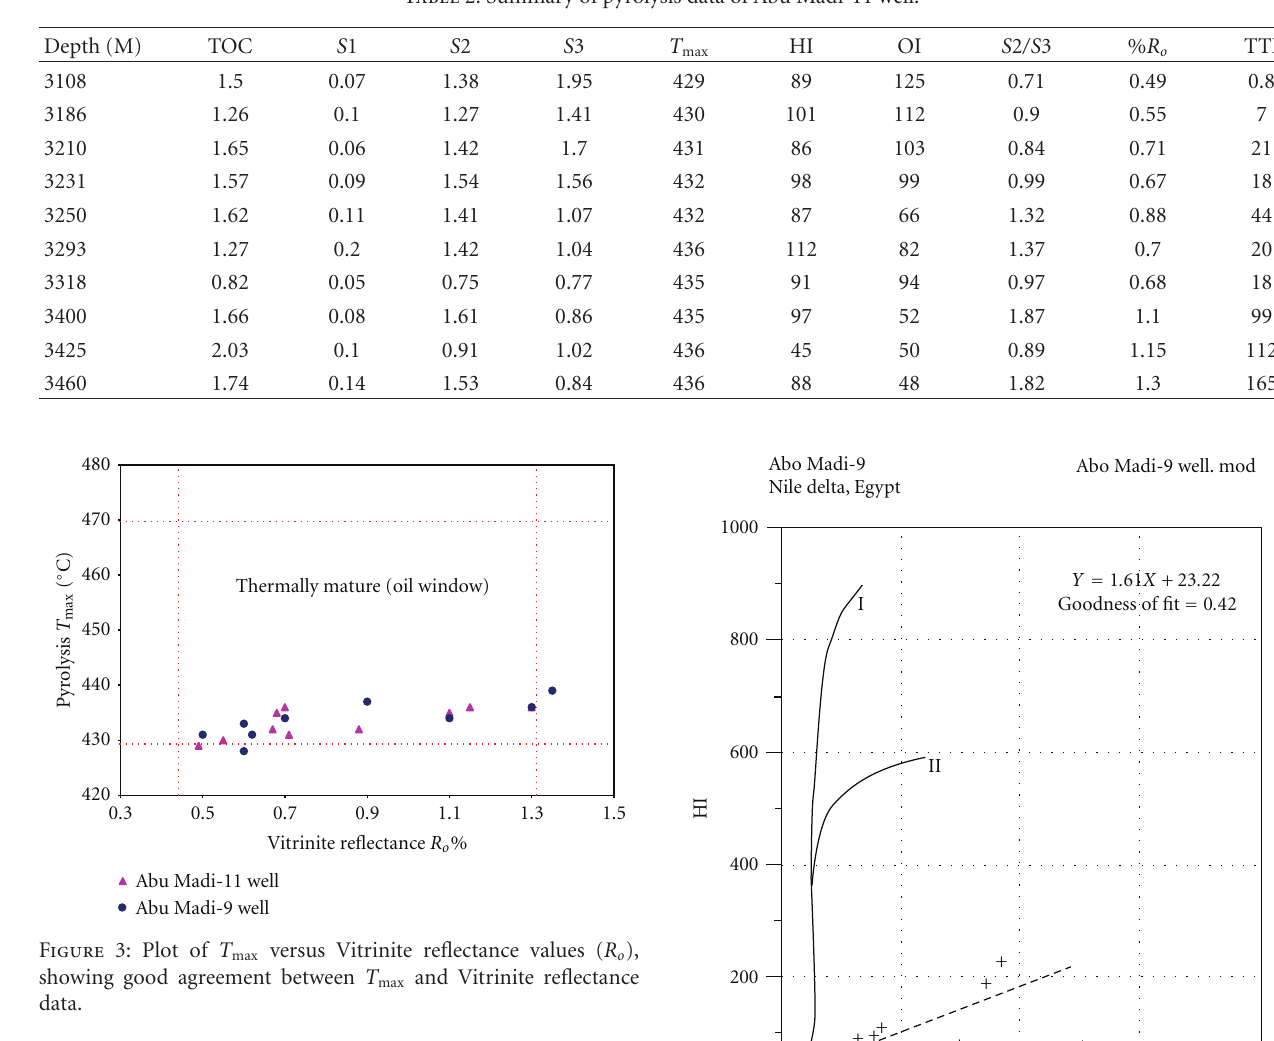
Table 2: Summary of pyrolysis data of Abu Madi-11 well.